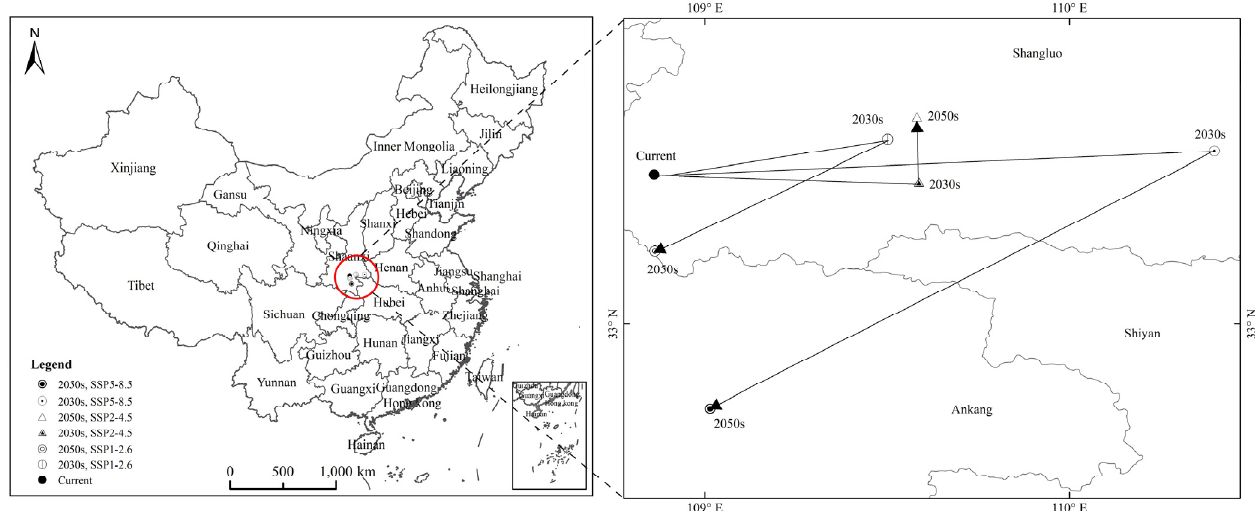
Figure 9. Changes in the centroid distributional shifts of Helicoverpa zea under climate change. Red circle: the centroid of potential geographical distribution of H. zea .